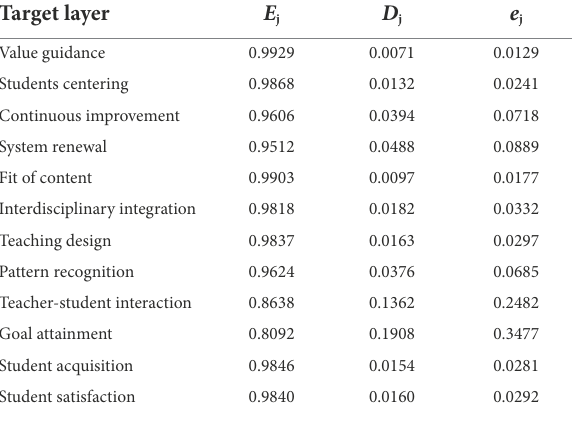
TABLE 5 Weight of each indicator of undergraduate course quality evaluation calculated by the entropy method.